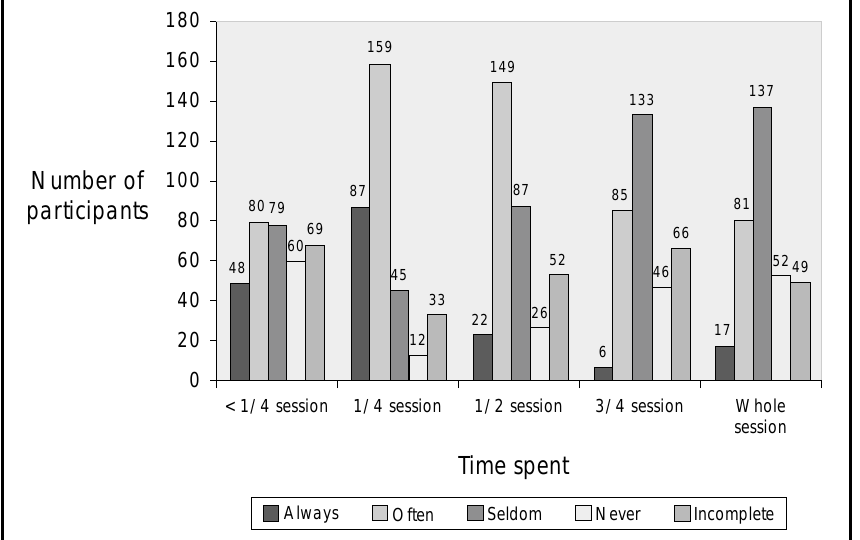
Figure 3: Time spent on exercise therapy during one treatment